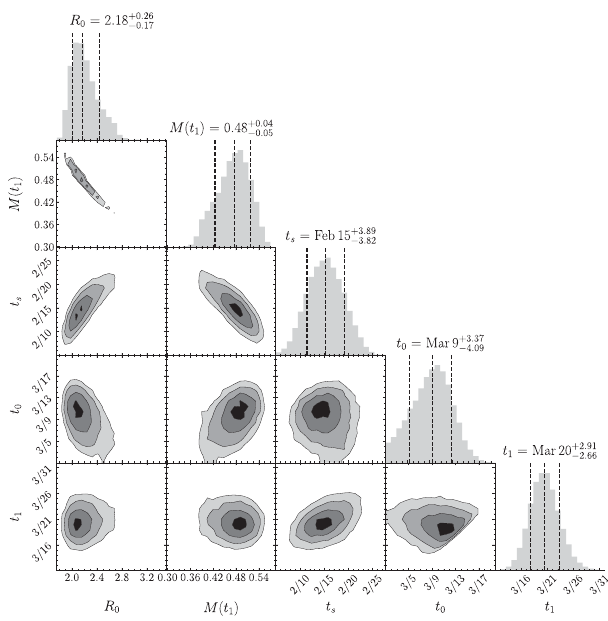
median.FIG. 5. Joint posterior distributions of pairs of the main parameters of our model fitted to the all-state data in Illinois up to May 17, 2020. The variables shown are the initial value of the reproduction number, R 0 ; the mitigation factor M ð t 1 Þ ; the start date of the epidemic, t s ; the day the mitigation factor begins to deviate from 1, t 0 ; and the day the mitigation reaches its asymptotic value, t 1